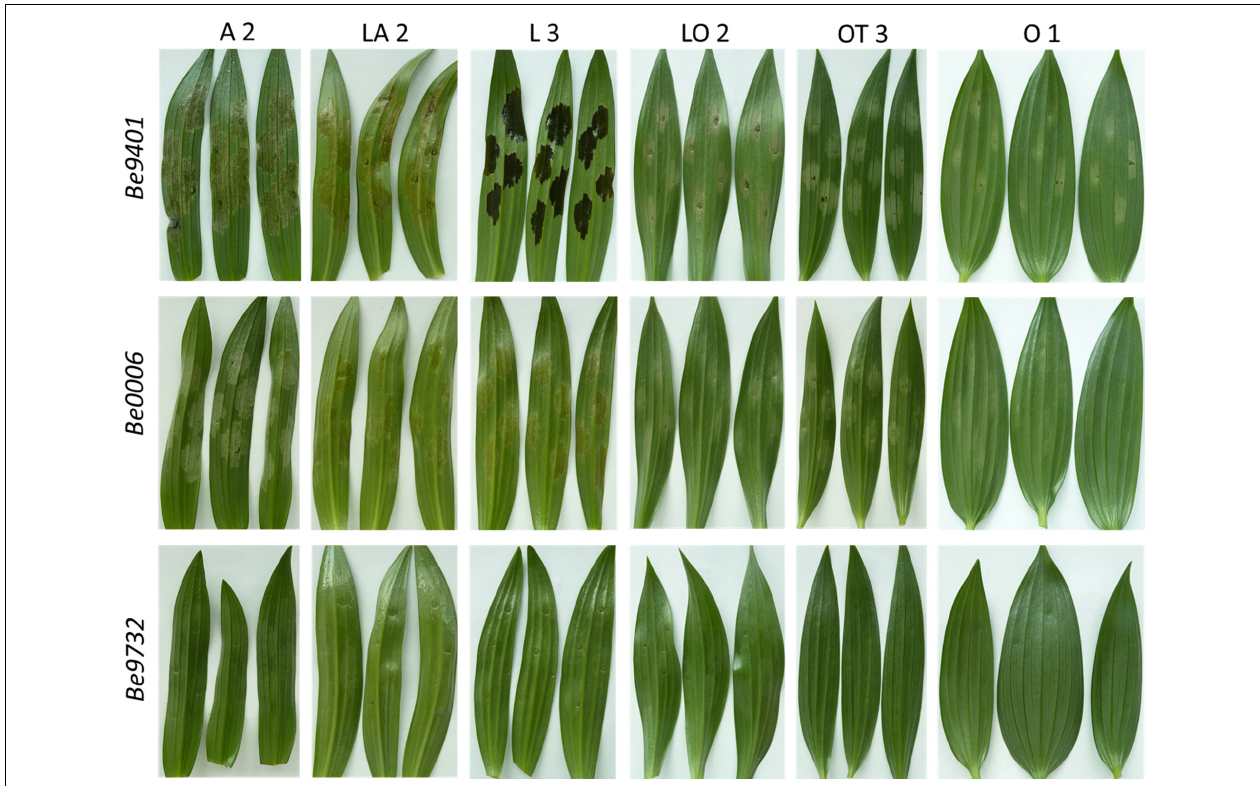
FIGURE 8 | Cell death symptoms caused by infiltration of CF samples obtained from liquid cultures of three B. elliptica isolates (specified in left margin) on leaves of six lily genotypes (specified at the